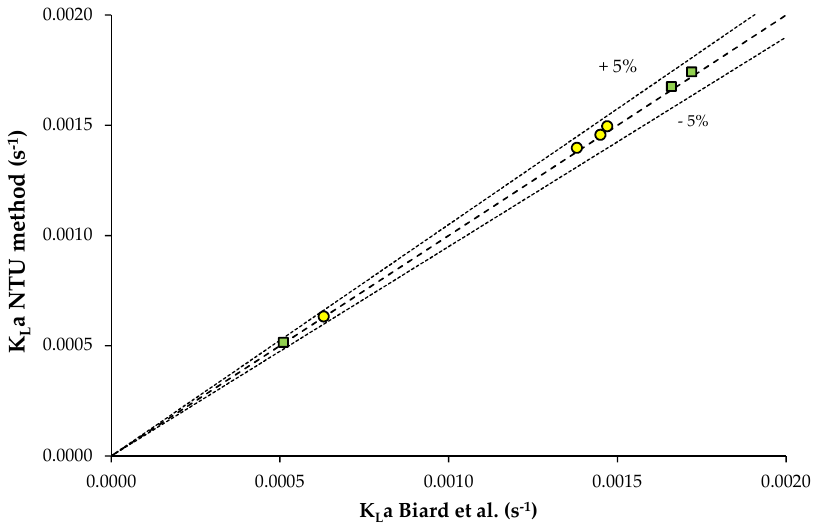
Figure 4. K L a parity plot obtained from the data analysis reported in Biard et al. [1] (circles: silicone oil; squares: DEHA; water data not provided by the authors).